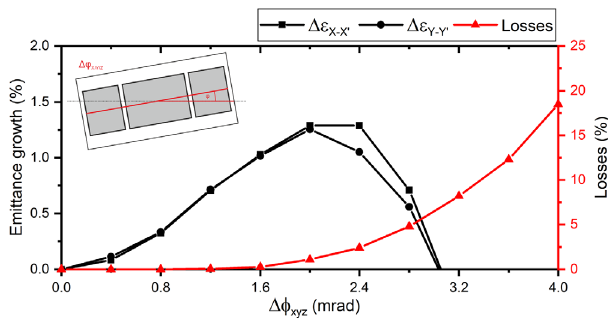
FIG. 30. The rms emittance growth and average losses for quadrupole triplet rotation around all three axes along the